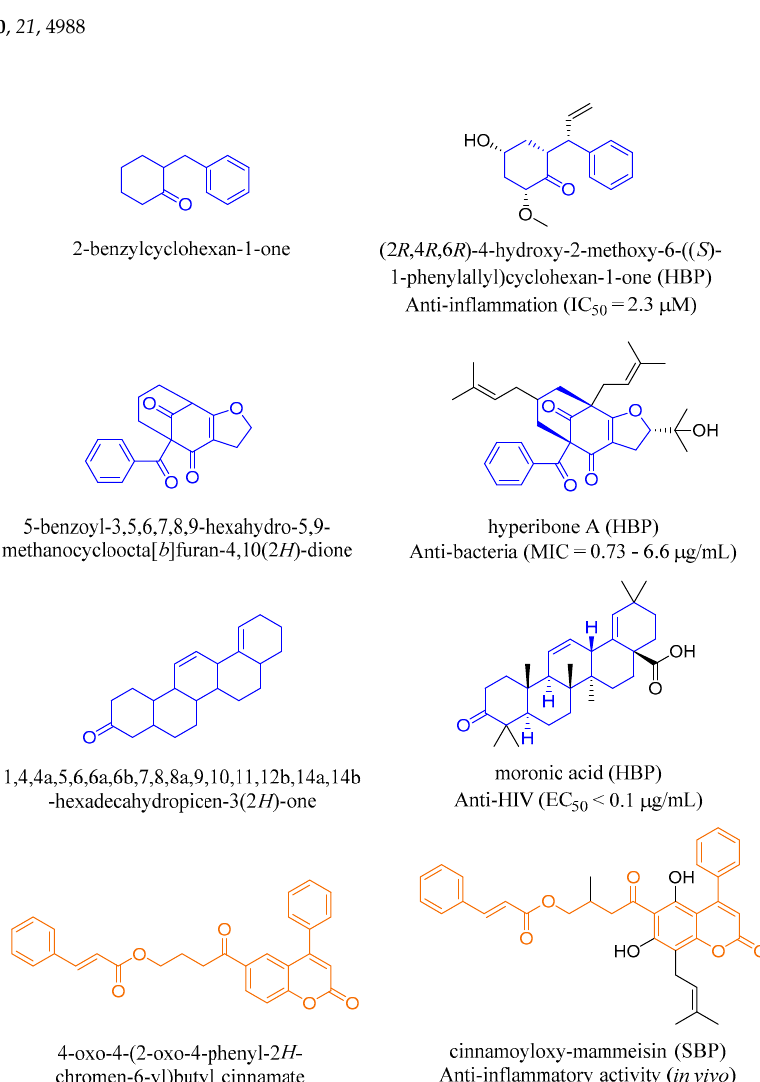
Figure 12. Examples of unique scaffolds and their representative compounds identified in HBP (blue) and SBP (orange).